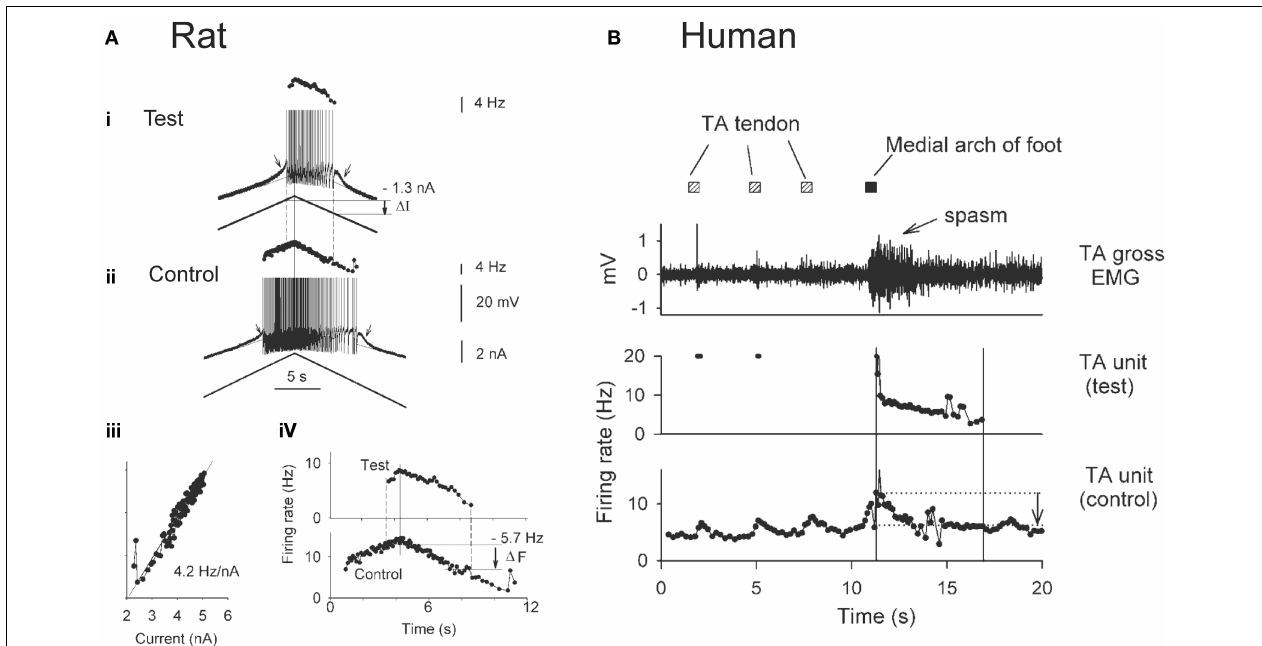
FIGURE 3 | Estimating PICs in rat and human motoneurons. (A) Rat motoneurons: Paired motor unit analysis ( (cid:2) F) technique in rat motoneurons. (i,ii) Firing rate profiles of a control and test motoneuron in response to the same triangular current injection. Measurement of PIC as the difference in current input at recruitment and derecruitment of the test motoneuron (dashed lines): (cid:2) I value. (iii) Linear relationship between the firing rate and injected current in the control motoneuron. (iv) The control motoneuron is serving as a measure of input to the test motoneuron. Measurement of the PIC as the difference in firing rate of the control motoneuron at recruitment